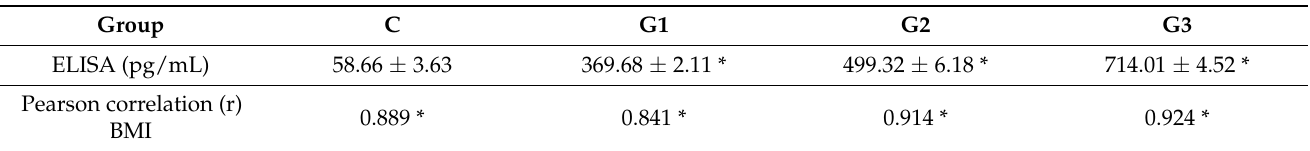
Table 4. Serum leptin concentration in the study and control groups together with the result of the Pearson correlation test ( p <0.05).